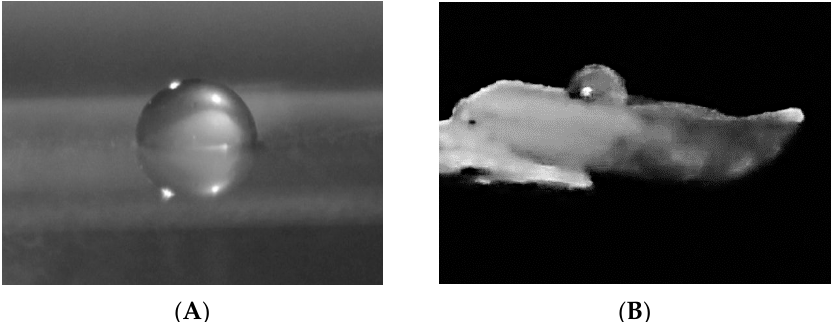
Figure 1. Frontal view of a drop of water deposited on ( A ) a glass microscope cover slip, and ( B ) on a peanut cotyledon. The intersection of solid–liquid–air where the contact angle is measured is noticeable